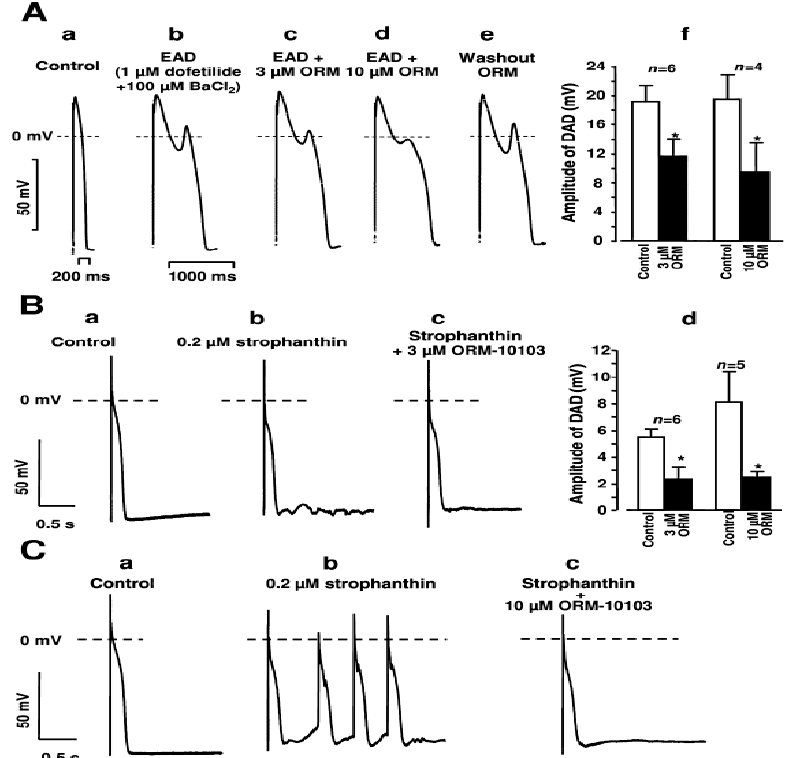
Figure 4. Effect of ORM-10103 against triggered activity. ( A ) ORM-10103 reduces the amplitude of EAD. ( a – e ) indicates the subsequent sections of the experiment. Bar graphs show the effect of ORM on EAD amplitude in 3 and 10 µ M ( f ). ( B ) ORM-10103 decreases the strophantin-induced membrane potential oscillations. ( a – c ) indicates the subsequent sections of the experiment, and bar graphs show the numerical data of the result ( d ). ( C ) ORM-10103 reduces the incidence of DADs. ( a – c ) indicates the subsequent sections of the experiment. * denotes p < 0.05. Reprinted with permission from Ref. [37]. 2022, Wiley.